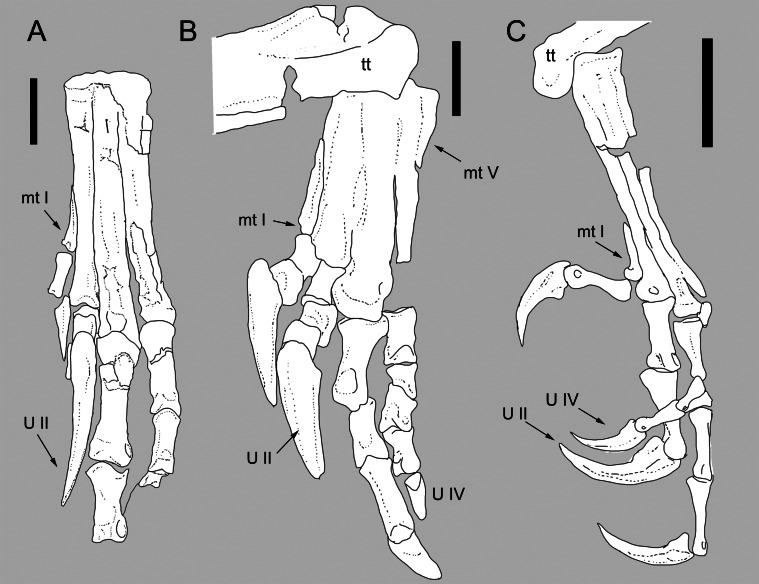
Comparison between the metatarsus of Balaur and other paravians.Comparison of the metatarsus and pes of (B) Balaur to that of (A) the dromaeosaurid Velociraptor; and (C) the pygostylian Zhouornis. (A) after Norell & Makovicky (1997, Figs. 6); (C) after Zhang et al.. (2013, Fig. 8, mirrored from original). Scale bar: 20 mm (A, B); 10 mm (C). Abbreviations: mt I, metatarsal I; mt V, metatarsal V; tt, tibiotarsus; U II: pedal ungual II; U IV, pedal ungual IV.